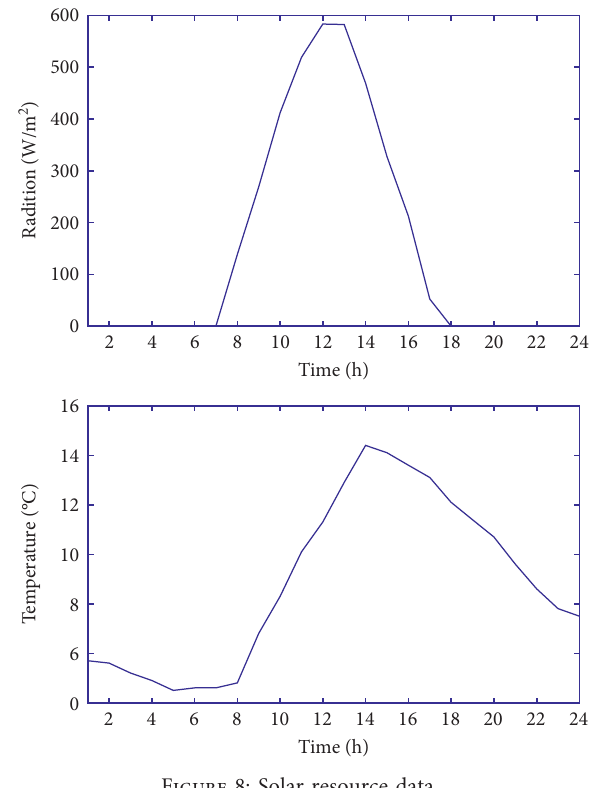
Figure 8: Solar resource data.